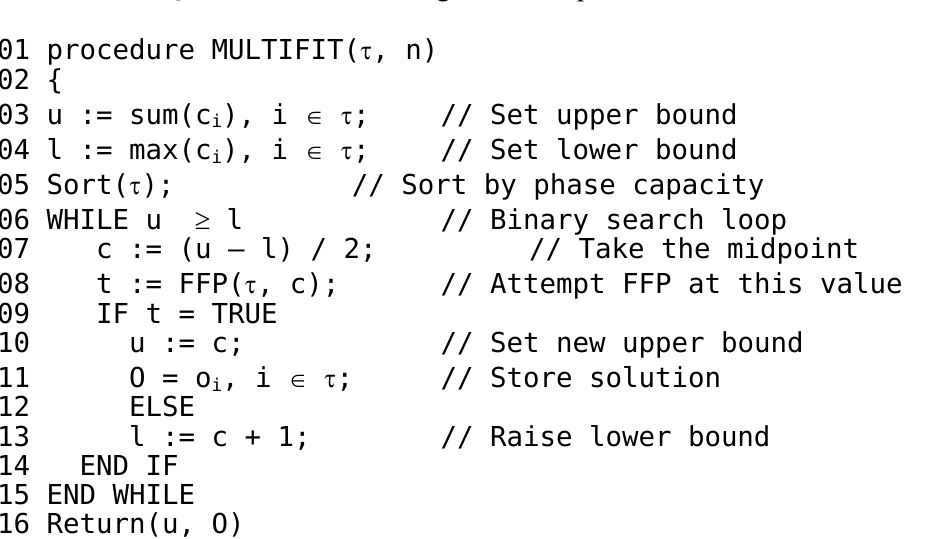
Figure 6. MULTIFIT algorithm, in